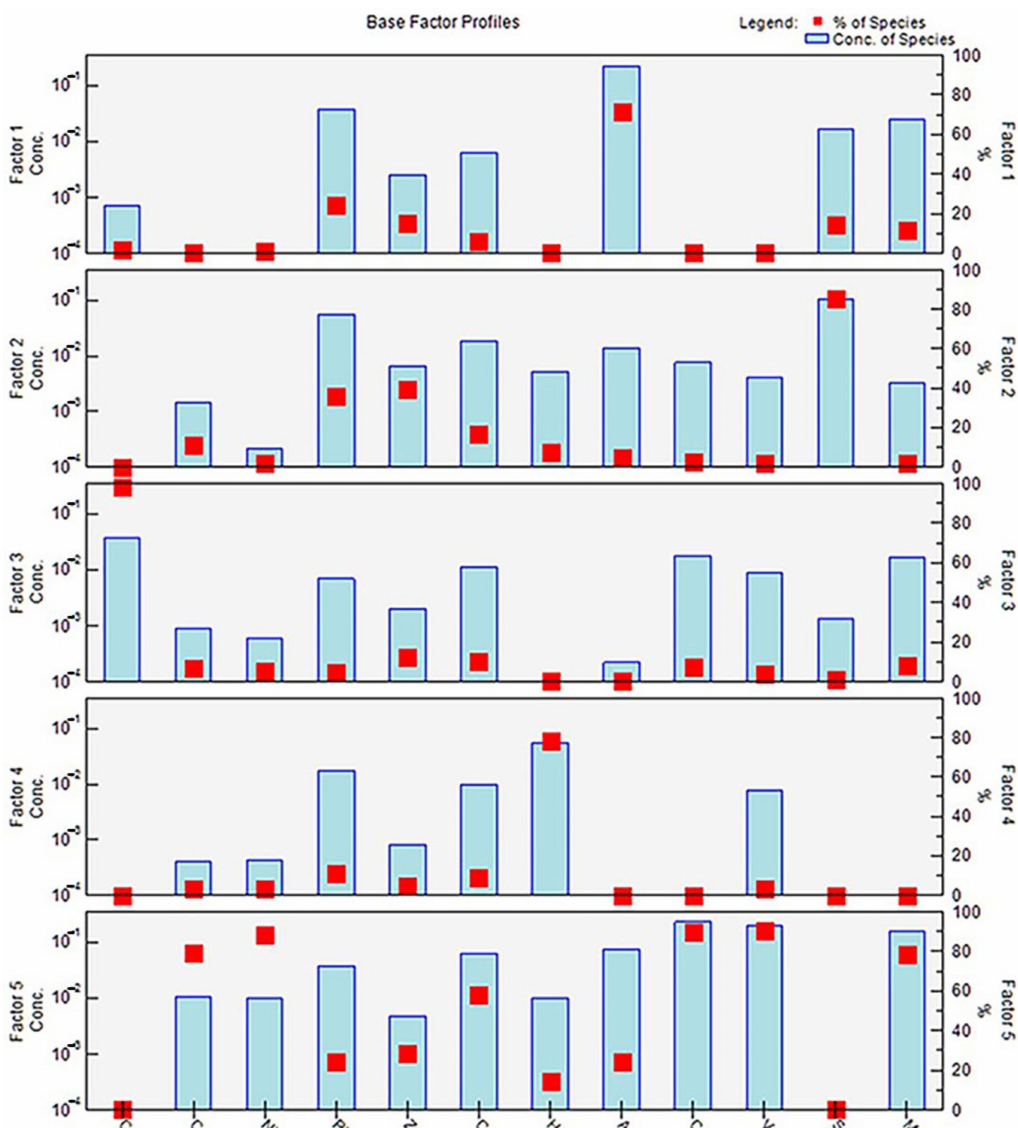
Figure 5. Source apportionment diagrams for the soil heavy metals based on the PMF model. Factor 5 contributed 79.39%, 88.59%, 58.52%, 90.14%, 90.59%, and 78.84% of the Cr,